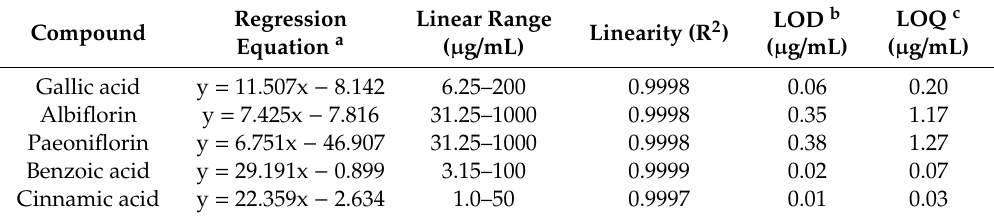
Table 1. Regression equation, linearity, LOD, and LOQ for five marker compounds (n = 3). Compound Regression Equation a